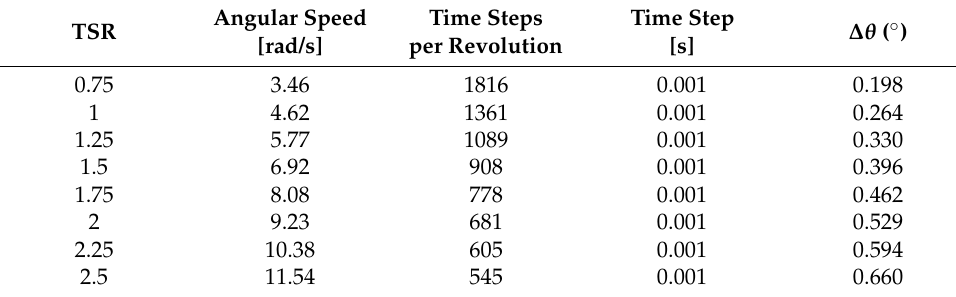
Table 6. TSR and time step used in the simulations.